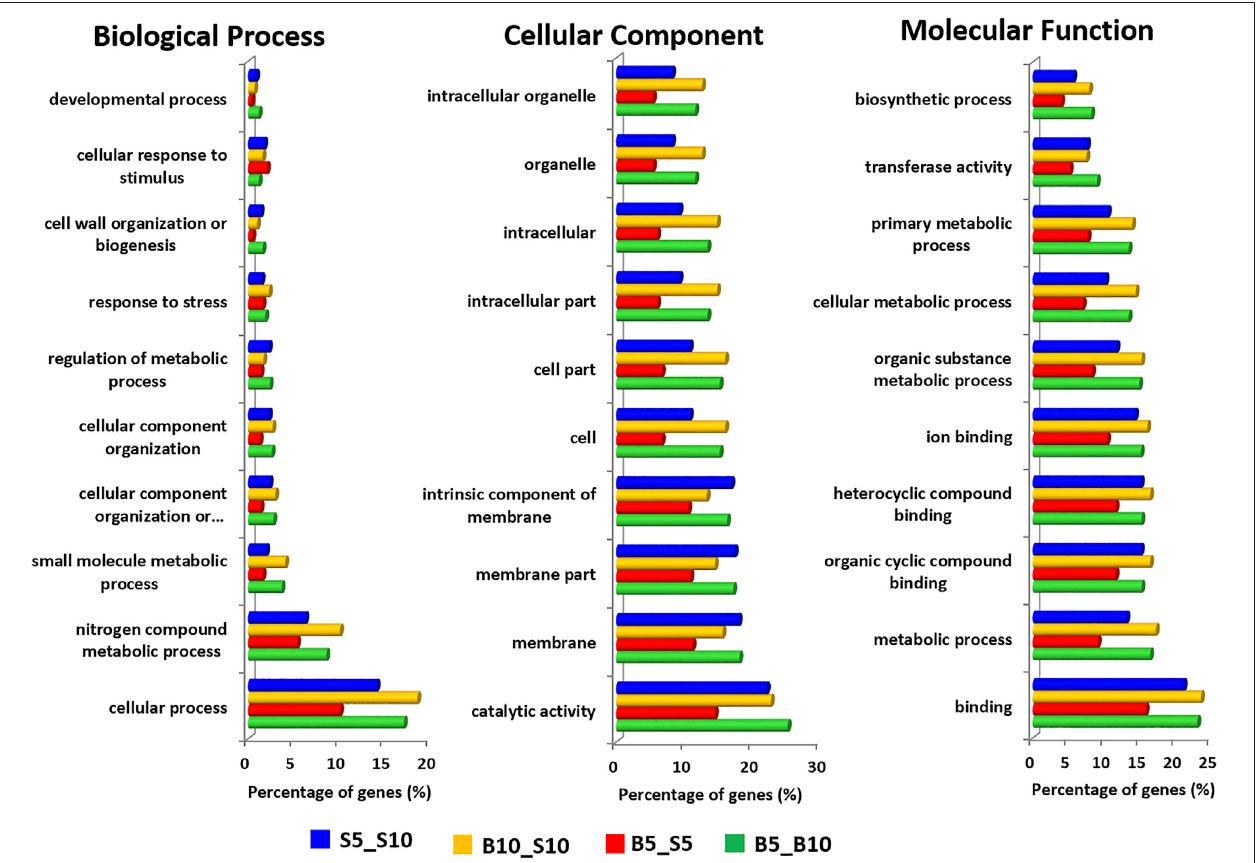
FIGURE 4 | Gene ontology (GO) annotation of differentially expressed genes in ricebean summarized in three main categories: biological process, cellular component, and molecular function.